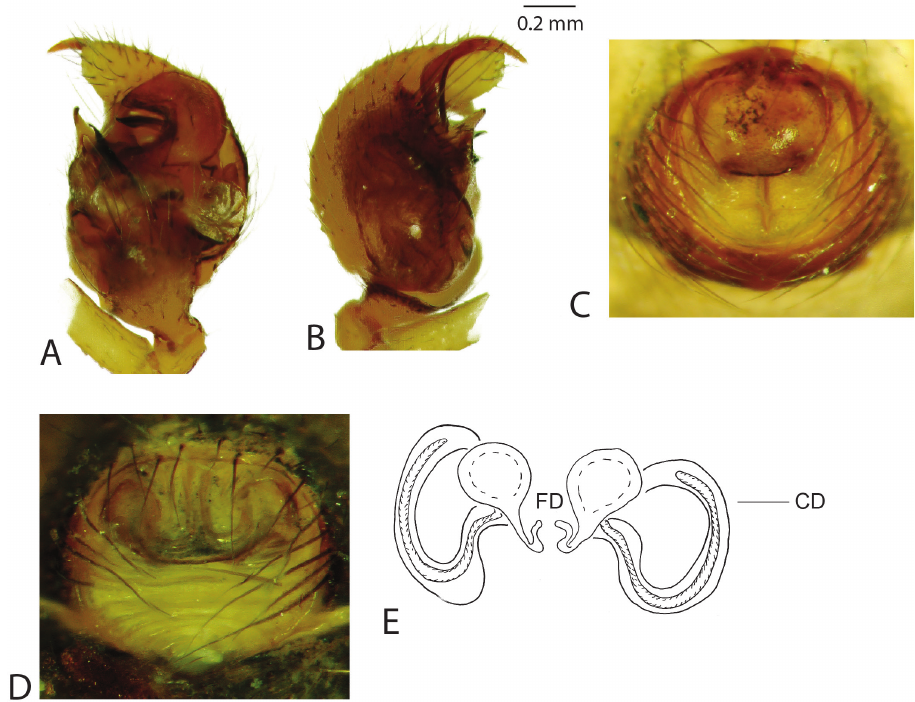
Figure 6. Anelosimus sallee : A–B palp, ventral, mesal C epigynum, ventral. Anelosimus andasibe : D–E epigynum, ventral,